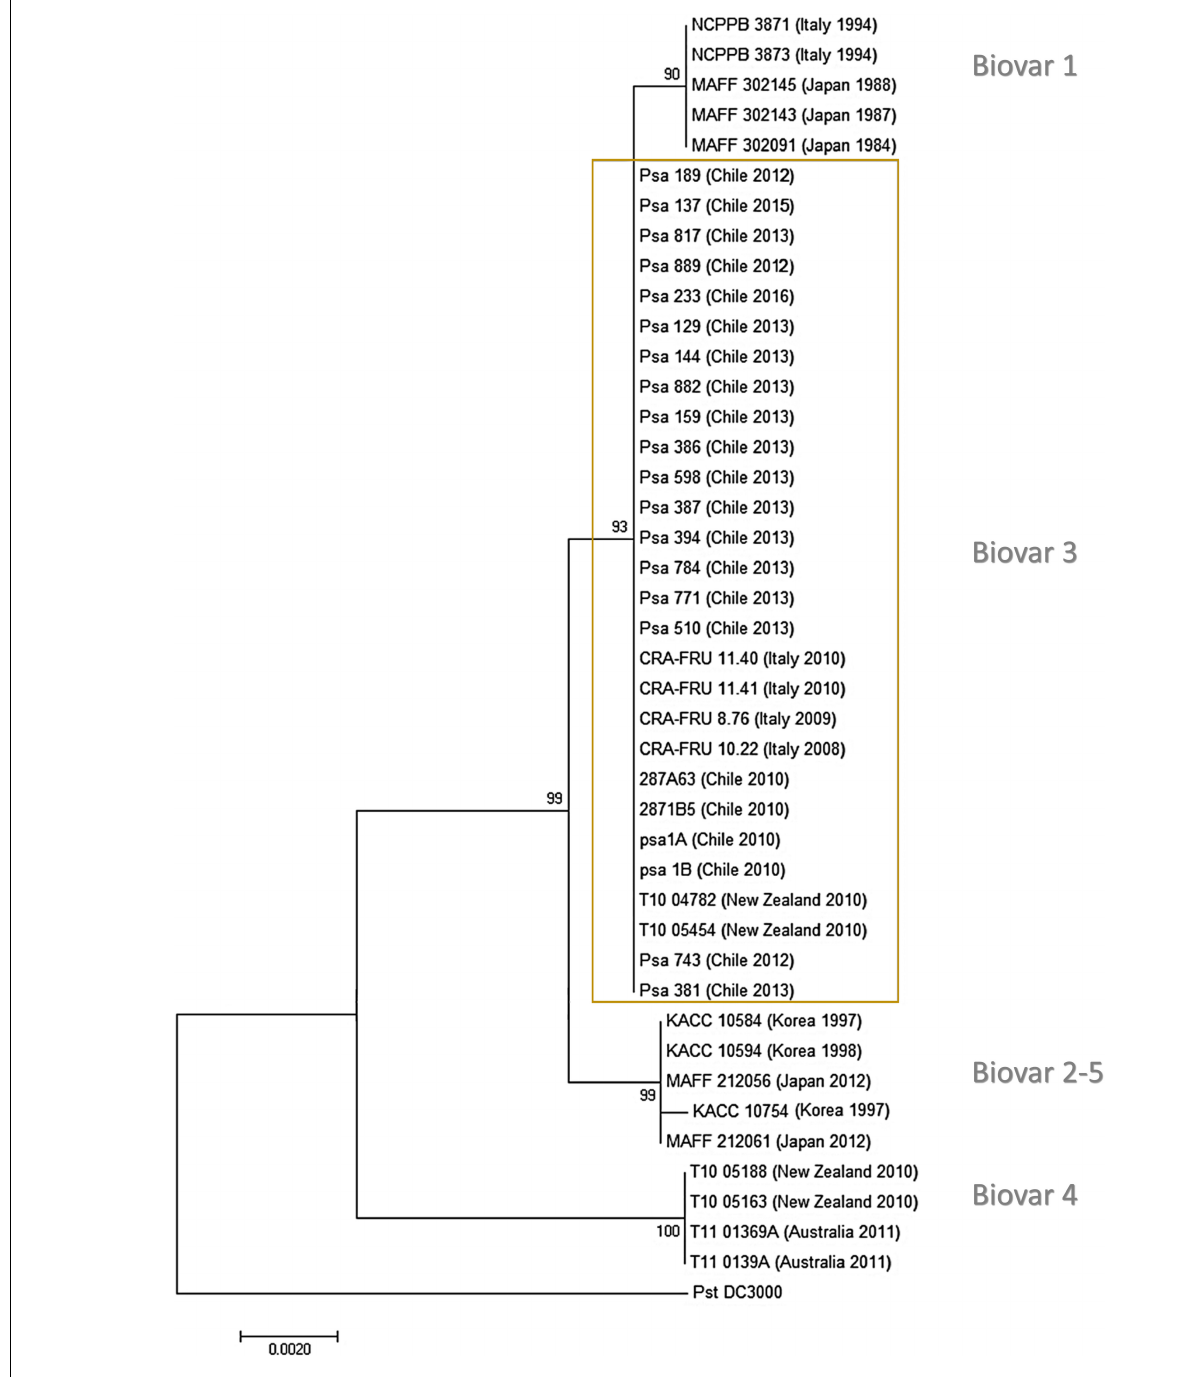
FIGURE 2 | Phylogenetic tree of Pseudomonas syringae pv. actinidiae isolates derived from multilocus sequence analysis (MLSA). Phylogenetic tree using the neighbor-joining method (bootstrap: 1,000 replicates) and concatenated sequences of the genes gapA , gltA , gyrB , and rpoB for each isolate. Country, year of isolation, and biovar clade are indicated for each